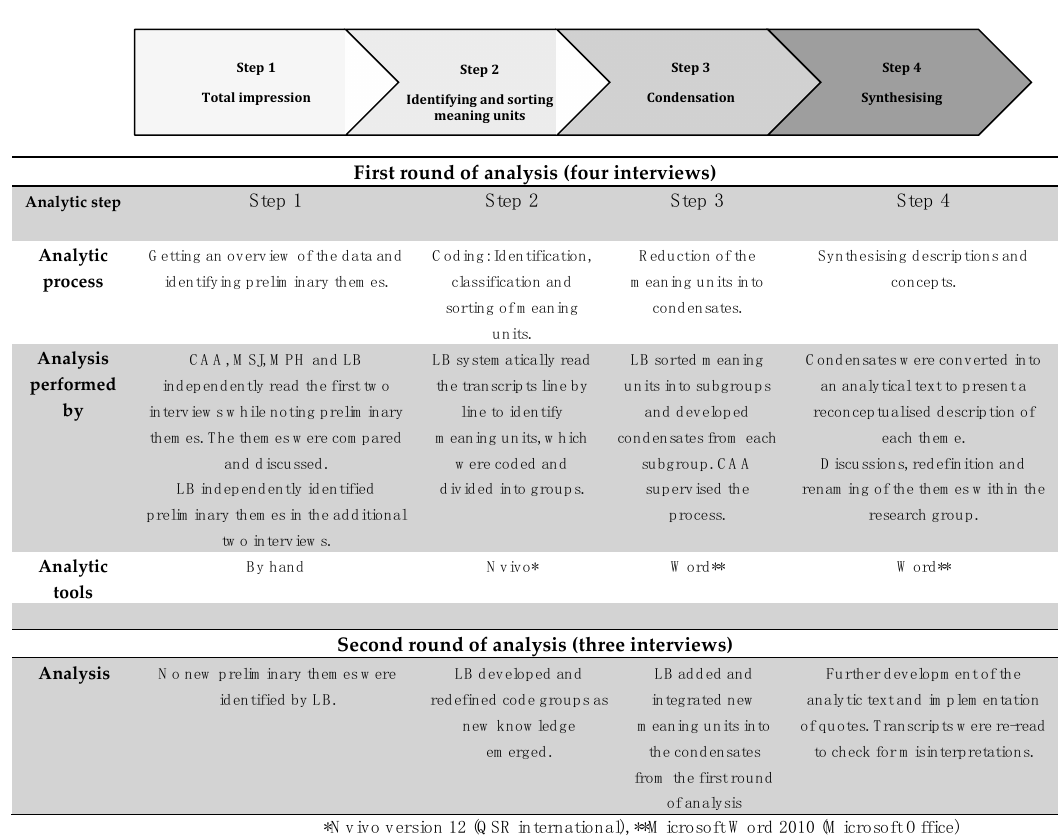
Figure 2. Overview of systematic text condensation in this